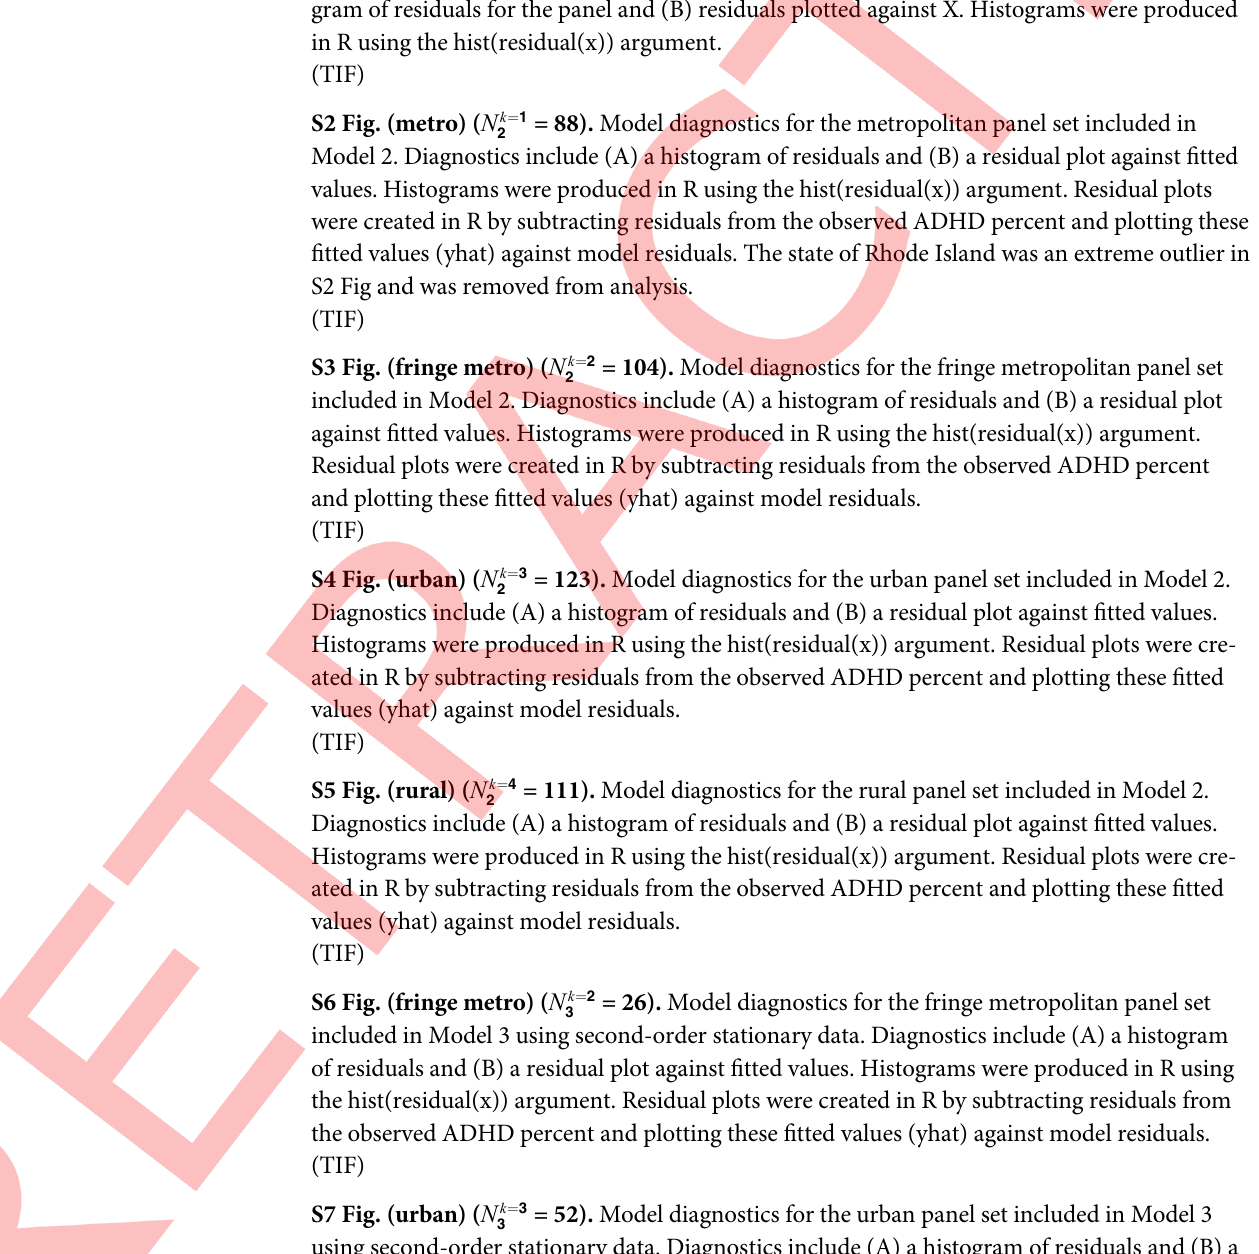
S2 Fig. (metro) ( N k ¼ 1